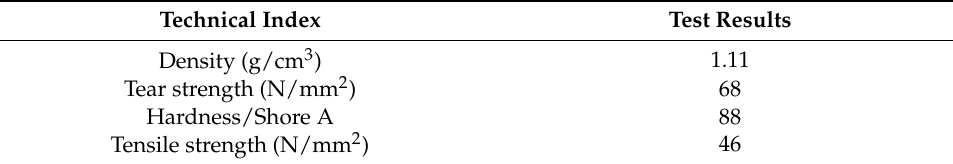
Table 2. Test results of the